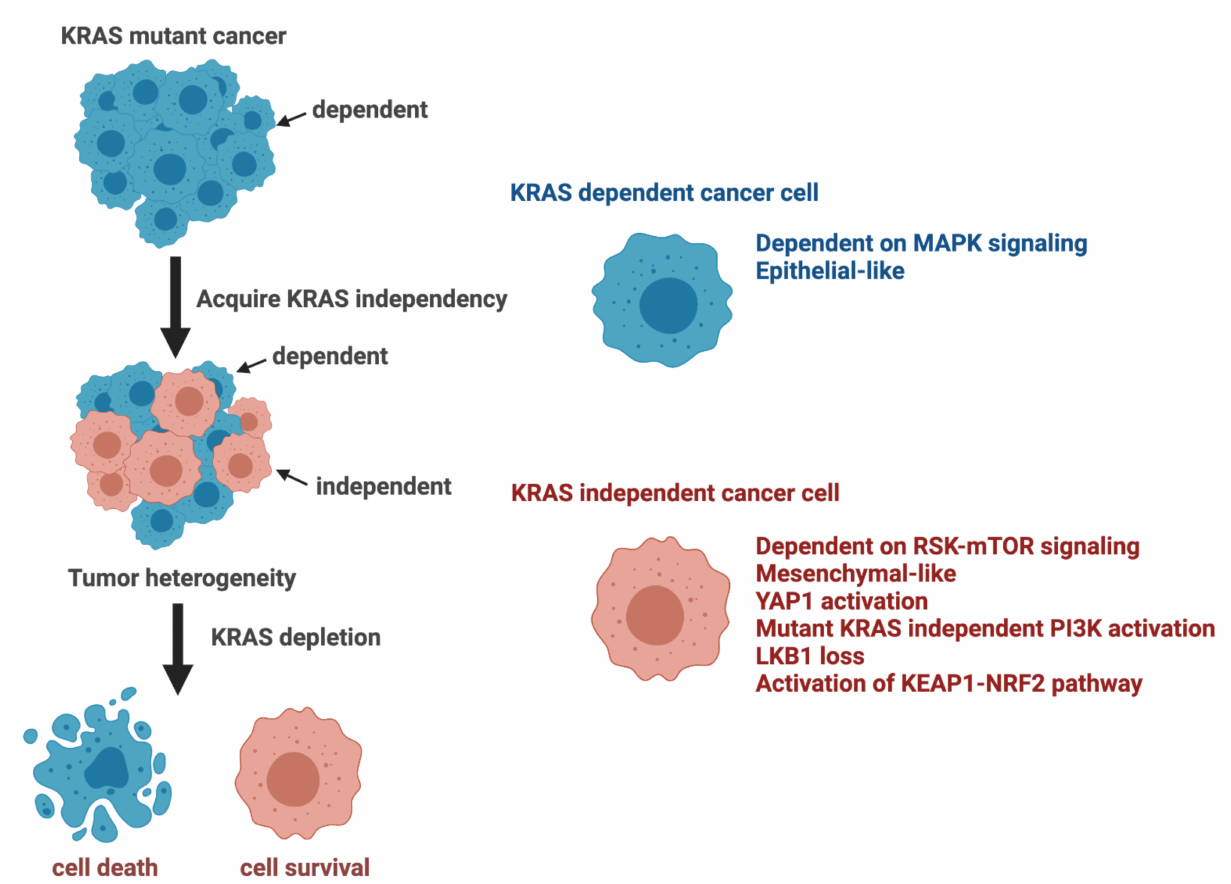
Figure 3. Phenotypes and activated pathways characteristically observed in KRAS-dependent and independent KRAS mutant cancer cells. Abbreviations: KEAP1, Kelch-like ECH-associated protein 1; KRAS, v-Ki-ras2 Kirsten rat sarcoma viral oncogene homolog; LKB1, liver kinase B1; mTOR, mammalian target of rapamycin; NRF2, Nuclear factor erythroid 2-related factor 2; PI3K, Phosphatidylinositol 3-Kinase; RSK, Ribosomal S6 kinase; YAP, Yes-associated Protein